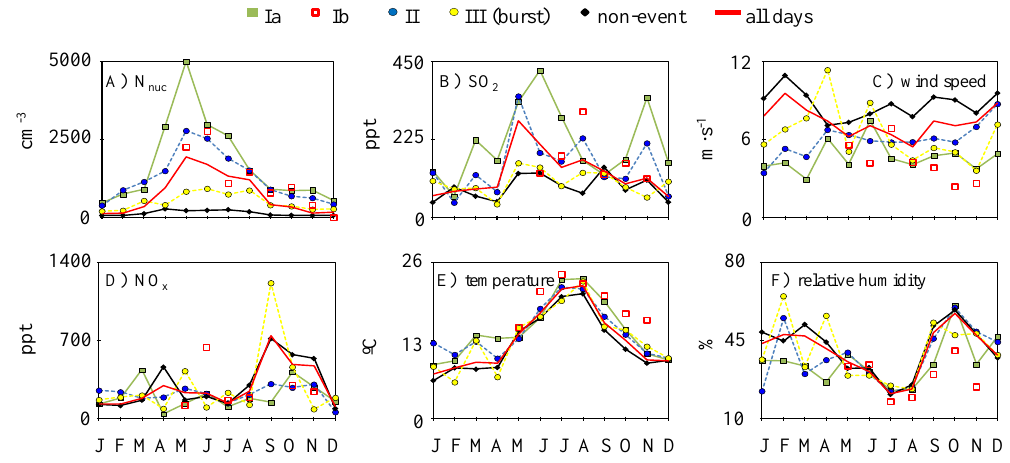
Fig. 11. Monthly mean values (calculated with hourly mean values from 11:00 to 16:00GMT) of a set of parameters during days in which episodes type Ia, Ib, II, III and non-event were registered. Mean values with all days of the months are also included.